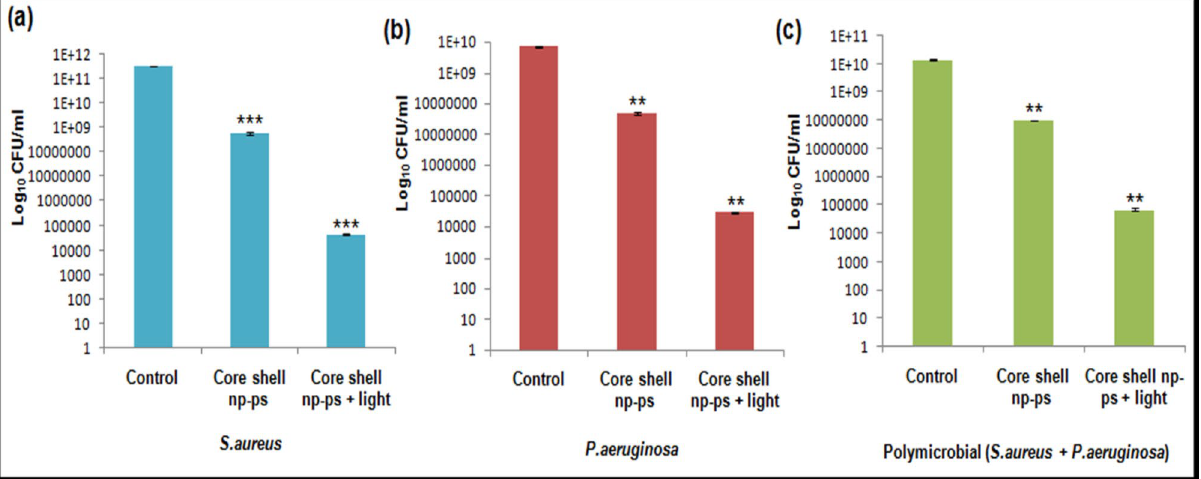
Figure 4. In vitro colony formation: ( a ) Monomicrobial S. aureus , ( b ) Monomicrobial P. aeruginosa and, ( c ) Polymicrobial S. aureus + P. aeruginosa colonies after incubation with TBO–chit–Au–AgNPs, TBO–chit– Au–AgNPs followed by irradiation with 630 nm laser for 12 min and 50 s which corresponds to 100 J/cm 2 at 0.1300 W/cm 2 . Data are presented as mean ± SD (n = 3) and normalized to that of untreated control. Three replicates were performed for each experiment. Statistical significance was determined using one-way analysis of variance ( p -value * p < 0.01, ** p < 0.001, *** p < 0.0001, ns = not significant).